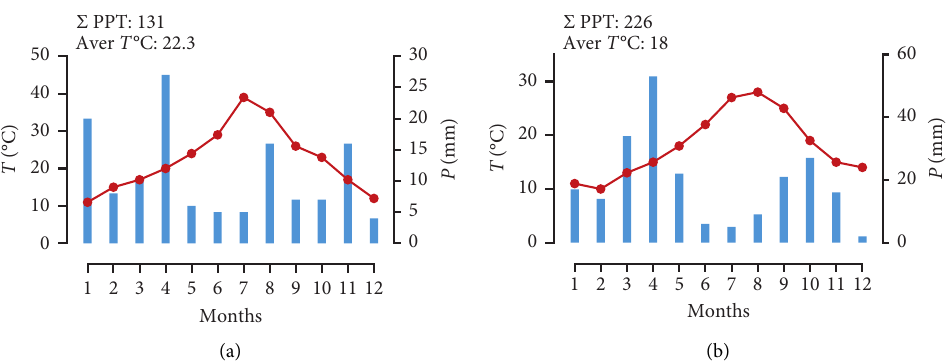
Figure 1: Average monthly meteorological data from the experimental station of the Faculty of Science in Oujda, for the experimental period January–December 2017 (a) and January–December 2018